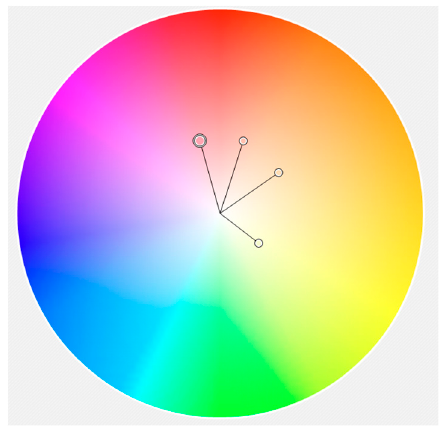
Figure 6. The OpenStreetMap color analysis.